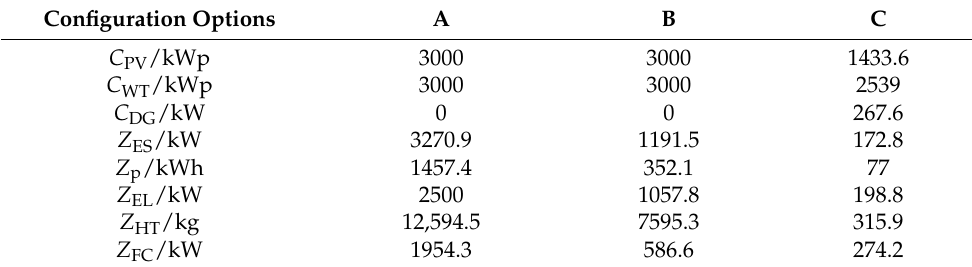
Table 8. Capacity Configuration Scheme for Each Equipment of Microgrid.